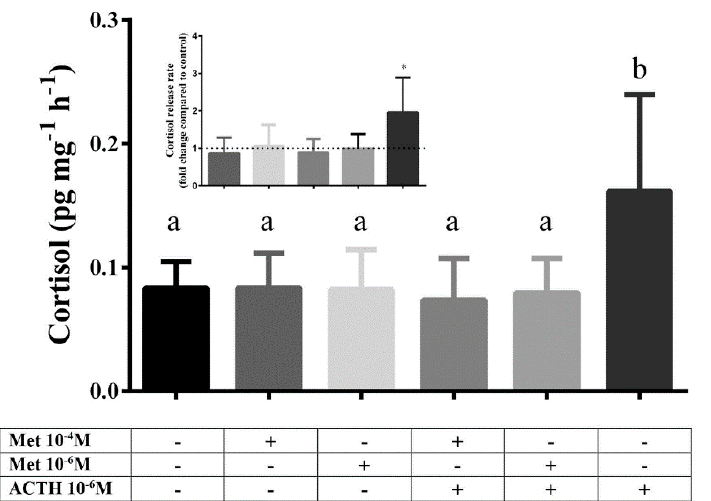
Figure 3. Cortisol release rate (pg cortisol per mg of scales per hour, pg mg − 1 h − 1 ) after 1 h in vitro incubation with different doses of metyrapone, ACTH and combination of metyrapone with ACTH. Results are expressed as average + SD (number of individuals in each trial n = 4, number of trials N = 2). Different letters indicate statistically significant differences between groups. Inlet: cortisol release rate expressed as fold change compared to control (dashed line). Asterisks indicate statistically significant differences compared to control.